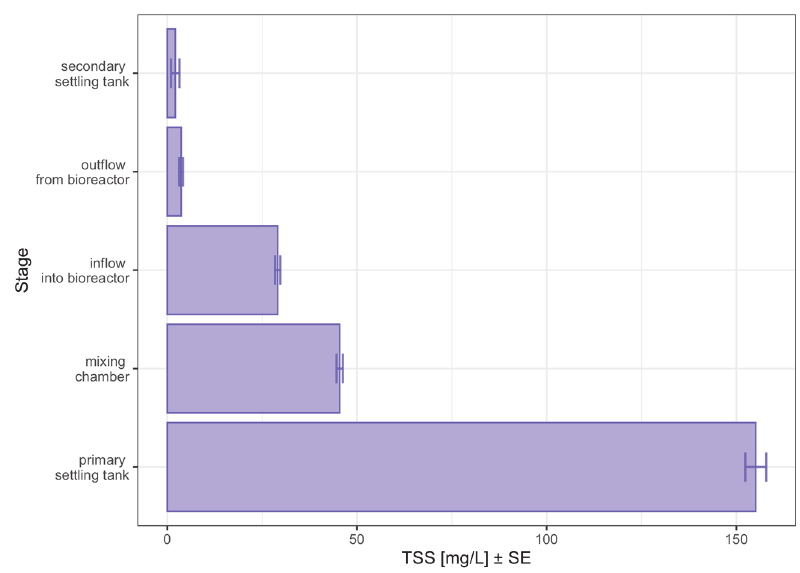
Figure 9. Graph of the level of total suspended solids (TSS) in the samples tested broken down by